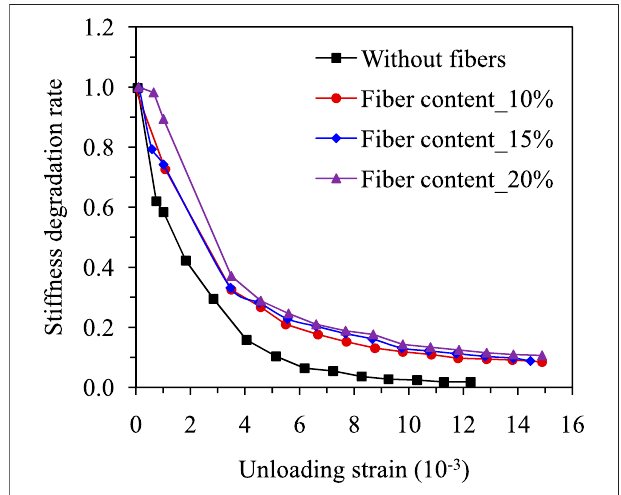
FIGURE 9 | Effect of fi ber volume fraction on stiffness degradation (Li et al.,